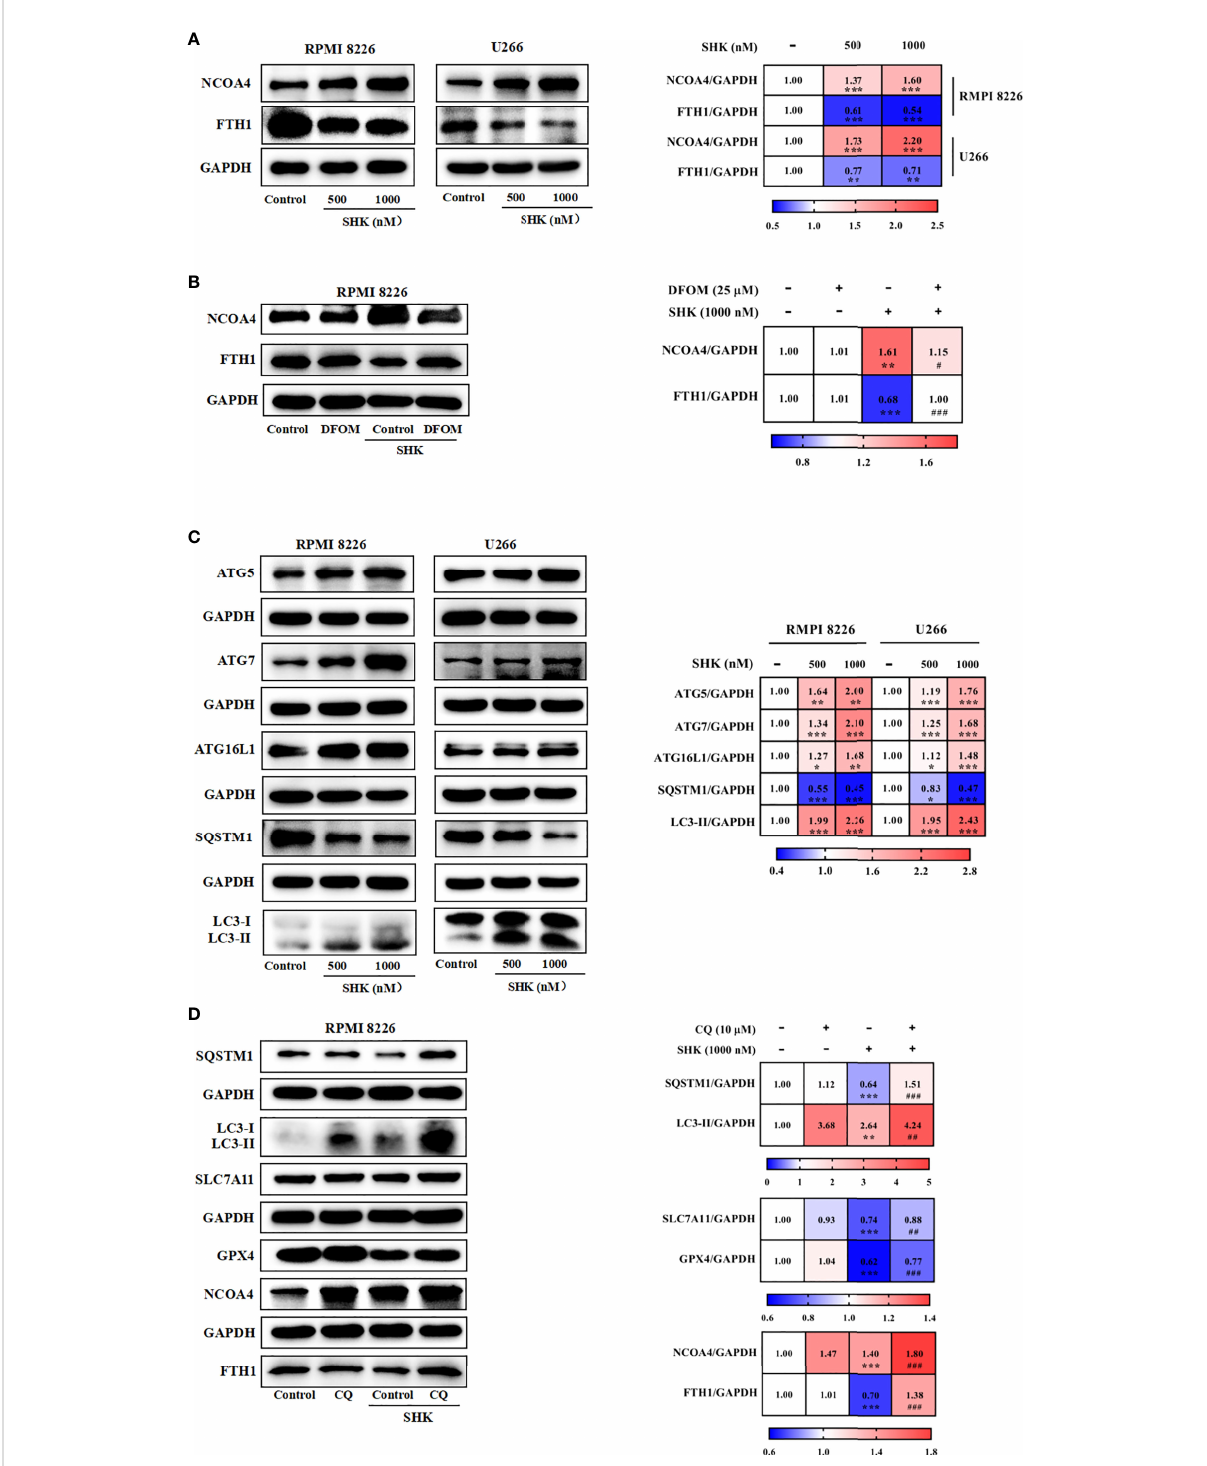
FIGURE 5 GOT1 inhibition primes for ferroptosis by promoting ferritinophagy. (A, B) The effects of SHK on protein level of FTH1 and NCOA4 were determined in the presence or absence of DFOM. (C) The protein level of ATG5, ATG7, ATG16L1, SQSTM1 and LC3B was examined after treatment with SHK for 24 h. (D) The effects of SHK on protein level of SQSTM1, LC3B, SLC7A11, GPX4, NCOA4 and FTH1 were determined in the presence or absence of CQ. Data are presented as the mean ± SD. * p < 0.05, ** p < 0.01, *** p < 0.001, compared to control; ## p < 0.01, ### p < 0.001, compared to